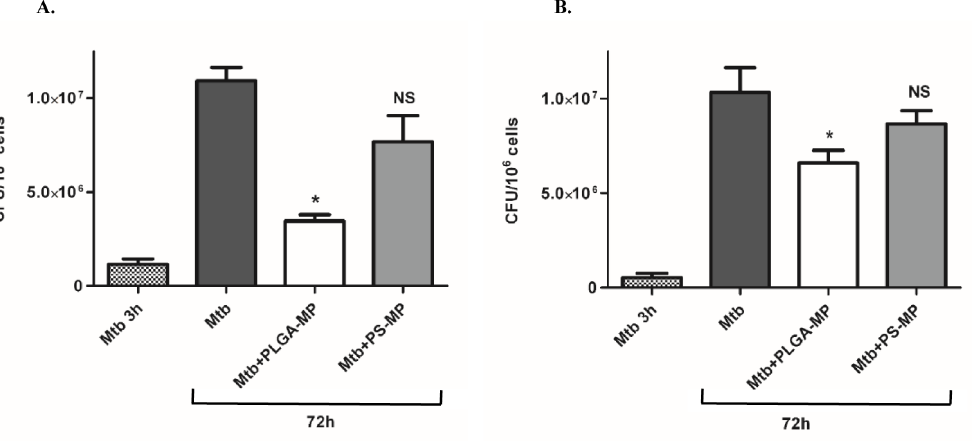
Fig 1. Drug-free PLGA MPs restrict the growth of Mtb in macrophages. PMA differentiated THP-1 cells were infected with (A) H37Ra or (B) H37Rv to reach an MOI of 1 – 5 phagocytosed bacilli per cell. The cells from several wells were lysed and serial dilutions were plated on Middlebrook 7H10 agar plates to determine the bacterial load at 3h (Mtb 3h). Cells in the remaining wells were left untreated (Mtb) or treated with 2.2 μ m PLGA MPs (Mtb+PLGA) or 1.8 μ m polystyrene (PS) MPs (Mtb+PS) for 1 hour at 37°C, 5% CO 2 after which the cells were washed and incubated for a further 72 hours. The cells were then lysed, combined with the medium and serial dilutions plated on Middlebrook 7H10 agar plates. The plates were incubated at 37°C for 14 – 21 days and colony forming units were counted. Results are expressed as mean +/- SEM, * p < 0.05 compared to untreated Mtb-infected cells. NS = not significant compared to untreated Mtb-infected